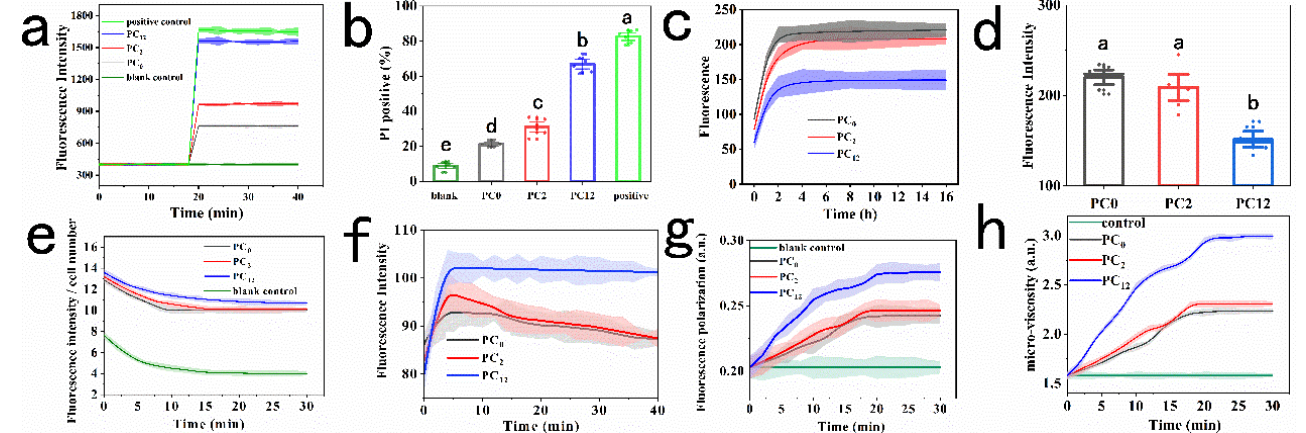
Figure 3. ( a ) Dynamic fluorescence of PI-staining S. cerevisiae cells following the treatments of nano- Se@PC 0 , nano-Se@PC 2 , or nano-Se@PC 12 combined with ultrasound. ( b ) S. cerevisiae cells membrane permeability at 20 min. ( c ) Dynamic fluorescence of DISC 3 (5)-treated S. cerevisiae cells. ( d ) Membrane potential at 10 min. ( e ) Dynamic changes in fluorescence intensity of BODIPY 581/591 C 11 )/cell numbers. ( f ) Dynamic changes of Δ ψ , ( g ) dynamic changes of fluorescence polarization, and ( h ) membrane micro-viscosity of S. cerevisiae cells treated with different nano-Se@PC + ultrasound. Different alphabetic letters indicate significant difference ( p < 0.05).